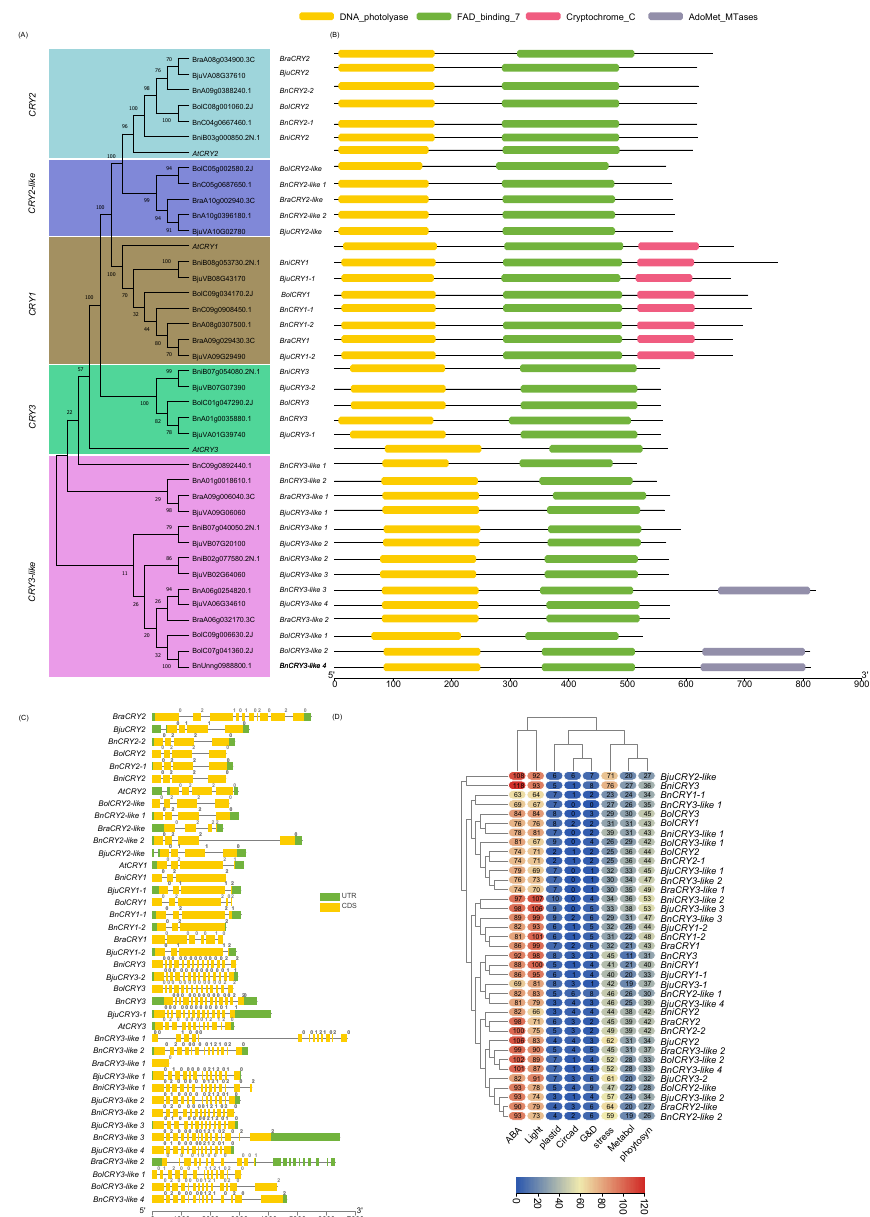
Figure 1. Phylogenetic analysis, classification, and structural description of cryptochrome (CRY) gene family in Brassica species. ( A ) The unrooted phylogenetic tree was established with Arabidopsis and five Brassica species ( B. rapa , B. oleracea , B. nigra , B. napus , and B. juncea ) CRY protein sequences using the neighbor-joining tree method with 1500 bootstrap replications in MEGA11. ( B ) Represents the domain architecture of phylogenetically classified CRY genes of Brassica species, while ( C ) represents the gene structures, including intron/exon pattern and intron phases (Class 0, 1, and 2) and UTRs. ( D ) Heatmap represents the key cis-regulatory elements (ABA- and light-responsive, elements associated with plastids, circadian rhythm, growth and development (G&D), stress, metabolite biosynthesis, and photosynthesis) and their abundance in putative promoter motifs of Brassica CRY genes reported in this